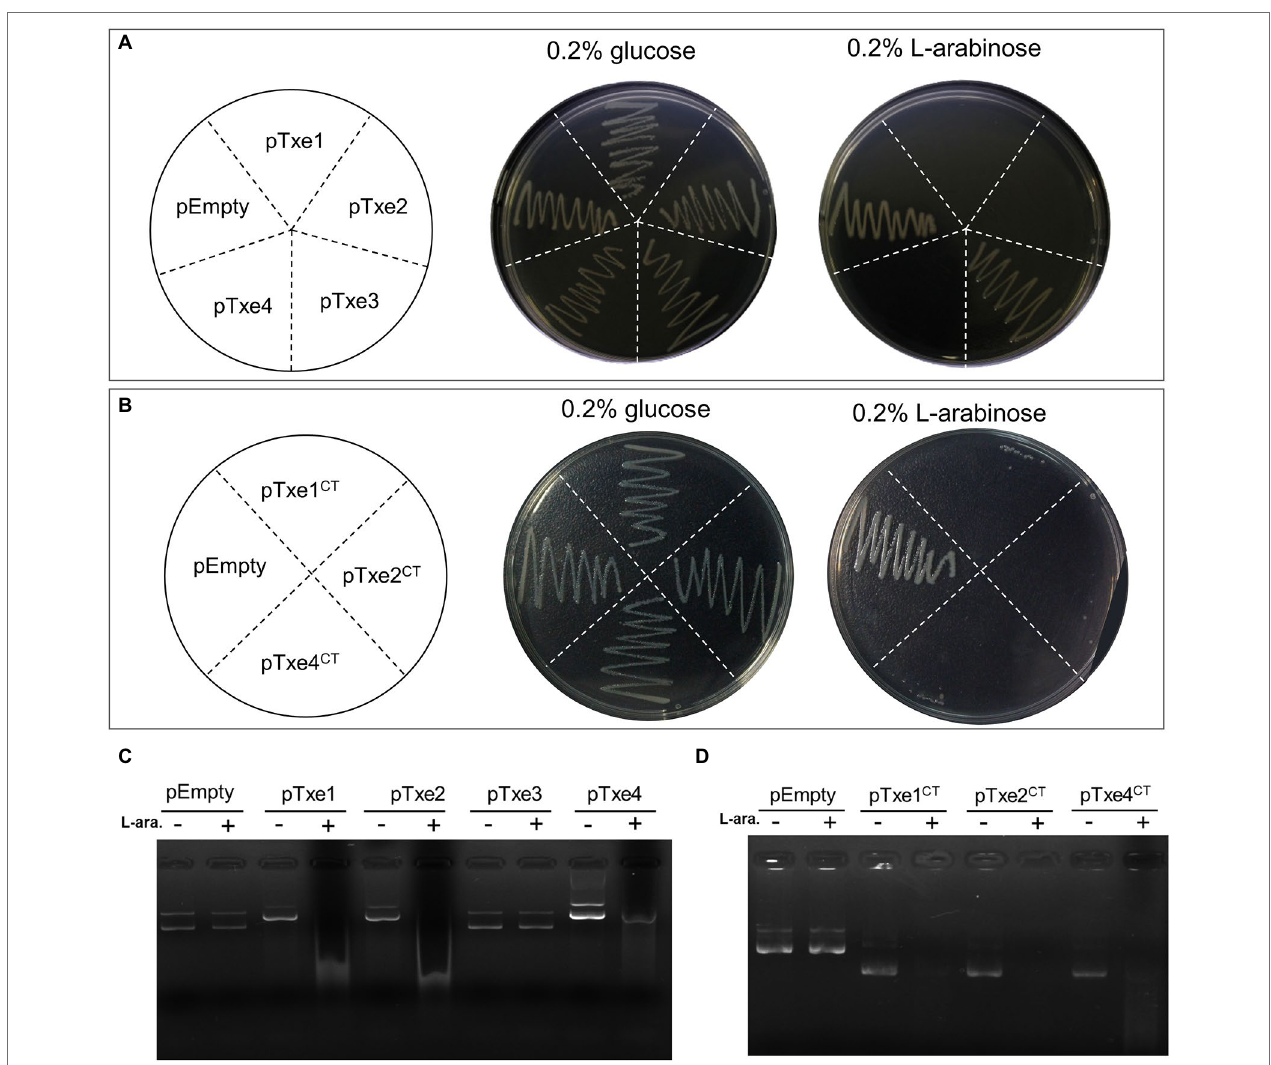
FIGURE 3 | Txe1, Txe2, and Txe4 are three DNase toxins. Txe1, Txe2, or Txe4 were expressed on arabinose-inducible expression plasmid pBAD33.1 vector in Escherichia coli BL21(DE3), and the growth of E. coli was tested by streaking on LB agar containing 0.2% L-arabinose (induction) and/or 0.2% glucose (repression). The E. coli toxicity was not observed for expressed Txe3 (A) . Toxicity of CT domains of Txe1 (residues 1,276–1,405), Txe2 (residues 984–1,107), and Txe4 (residues 1,276–1,408) expressed in E. coli BL21(DE3) from arabinose-inducible expression plasmids (B) . Induced expression of full-length (C) or C-terminal extension (D) of Txe1, Txe2, or Txe4 for 3 h resulted in plasmid DNA degradation in vivo . Degradation was not observed for expressed Txe3. + And − symbols indicate addition or not of L-arabinose, respectively. The pBAD33.1 was transformed into E. coli BL21(DE3) to act as an empty vector control (pEmpty) for all assays. Representative data from three independent experiments are